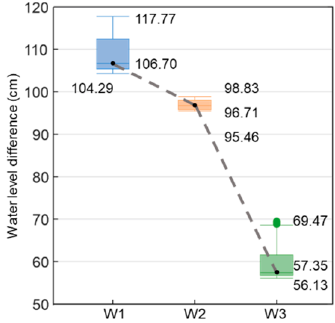
Figure 12. Box plot of water level differences between water level meters and sensors.